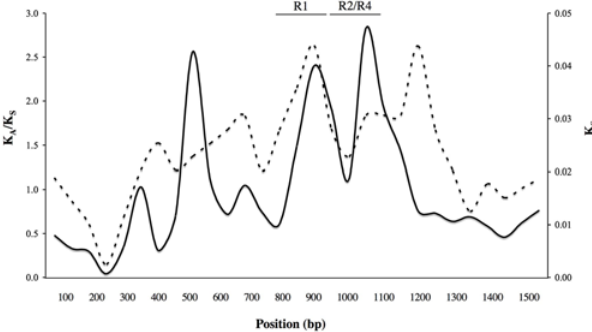
Figure 1. K A /K S (solid line, left y-axis) varies greatly along the length of the SEP53 coding region based on a sliding window analysis. K S (dotted line, right y-axis) is also shown. Data are from primates only and is the mean of all pairwise comparisons involving humans. The window size was 100 bp, the step size 20 bp; varying these parameters has some effect on the output, but all combinations of window and step size consistently indicated a K A /K S trough in the N-terminal Ca + binding domain (bp 0 to 270) and prominent peaks in the C-terminal domain (bp 271 onwards) around bp 500, 900, and 1100. The location of two repeats common to all primates are indicated as R1 and R2/R4 (see figure 2).